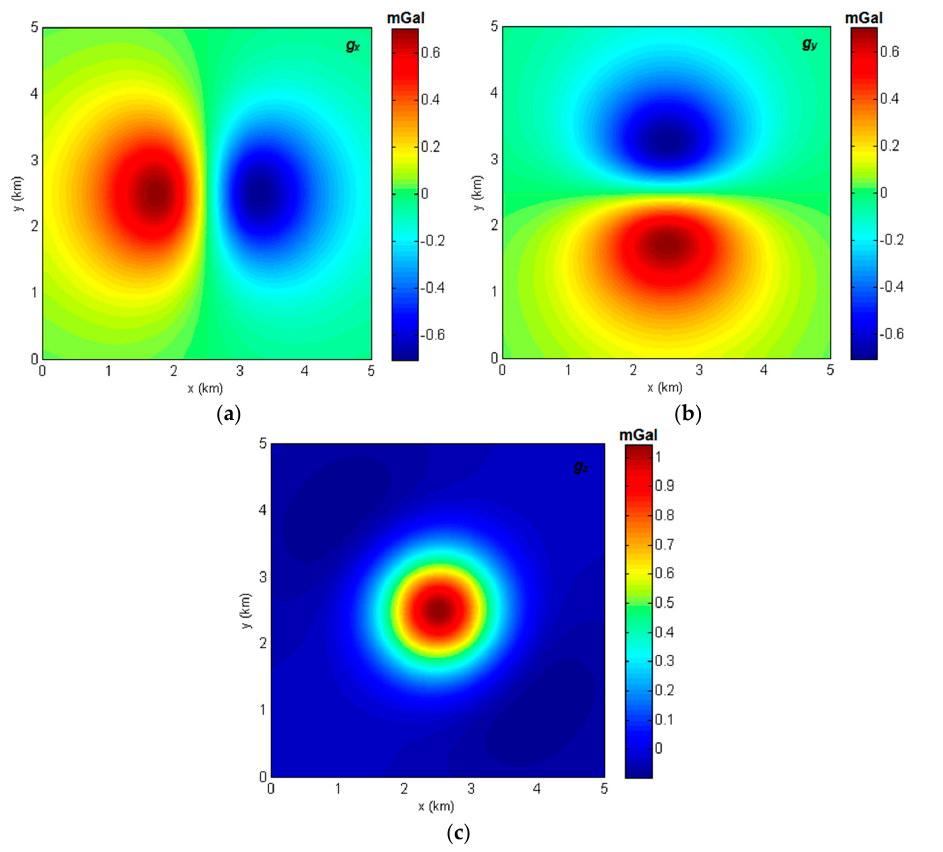
Figure 6. The gravity field anomaly components based on rectangular prism in Cartesian system coordinates ( a ) g x ; ( b ) g y ; ( c ) g z .